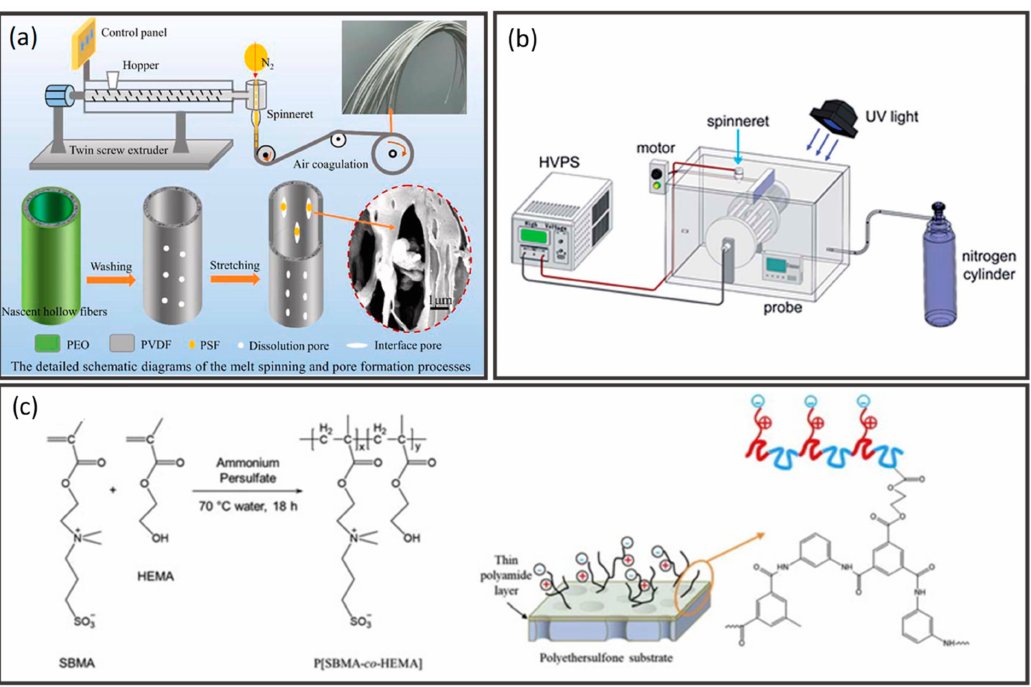
Figure 19. Schematic diagram of ( a ) melt-spinning technique with proposed stretching mecha- nism [656] and ( b ) UV light-assisted electrospinning method. Reprinted/adapted with permission from Refs. [656,657]. Copyright 2016 and 2021, Elsevier and Royal Society of Chemistry. ( c ) Copoly- mer synthesis via free radical polymerization with the proposed grafting mechanism where copoly- mer reacts with residual acyl chloride groups on the polyamide surface. Reprinted/adapted with permission from Ref. [664]. Copyright 2019,